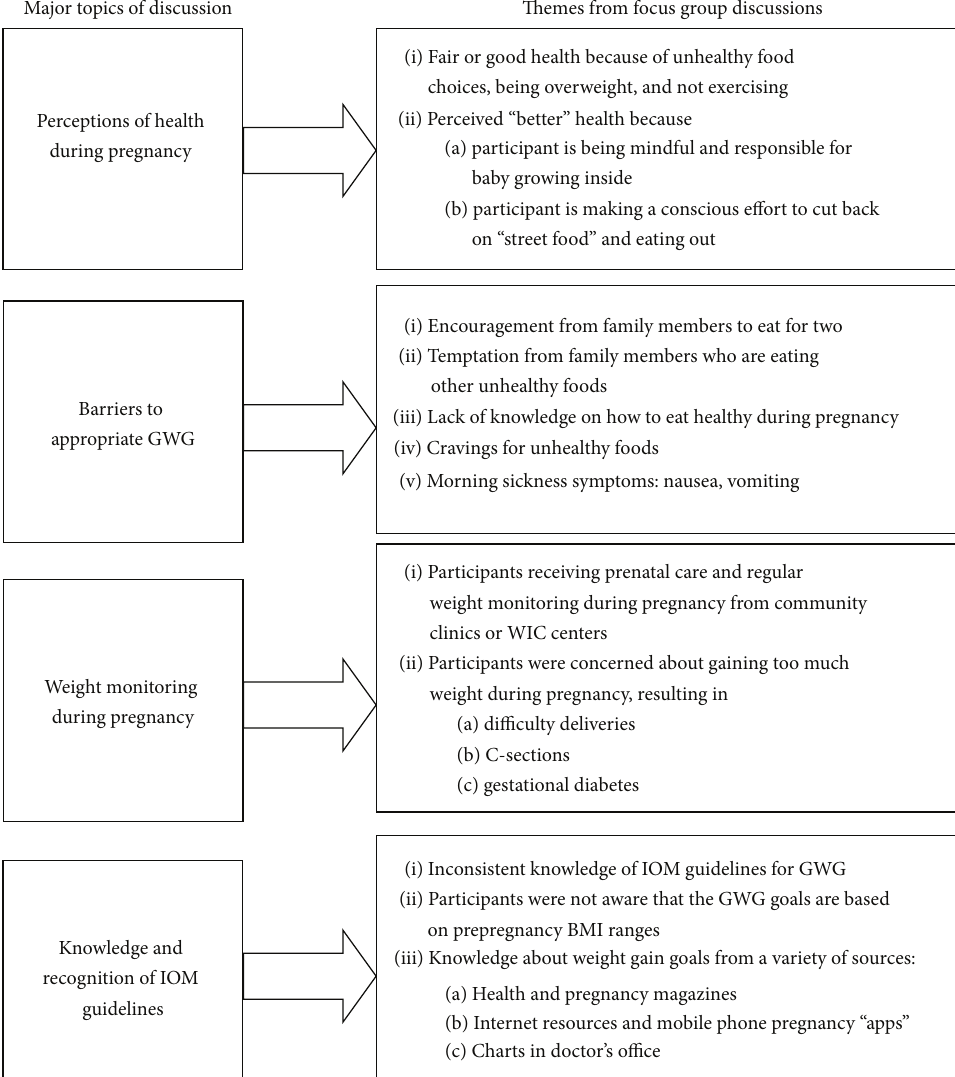
Figure 1: Overview of focus group topics and emerging